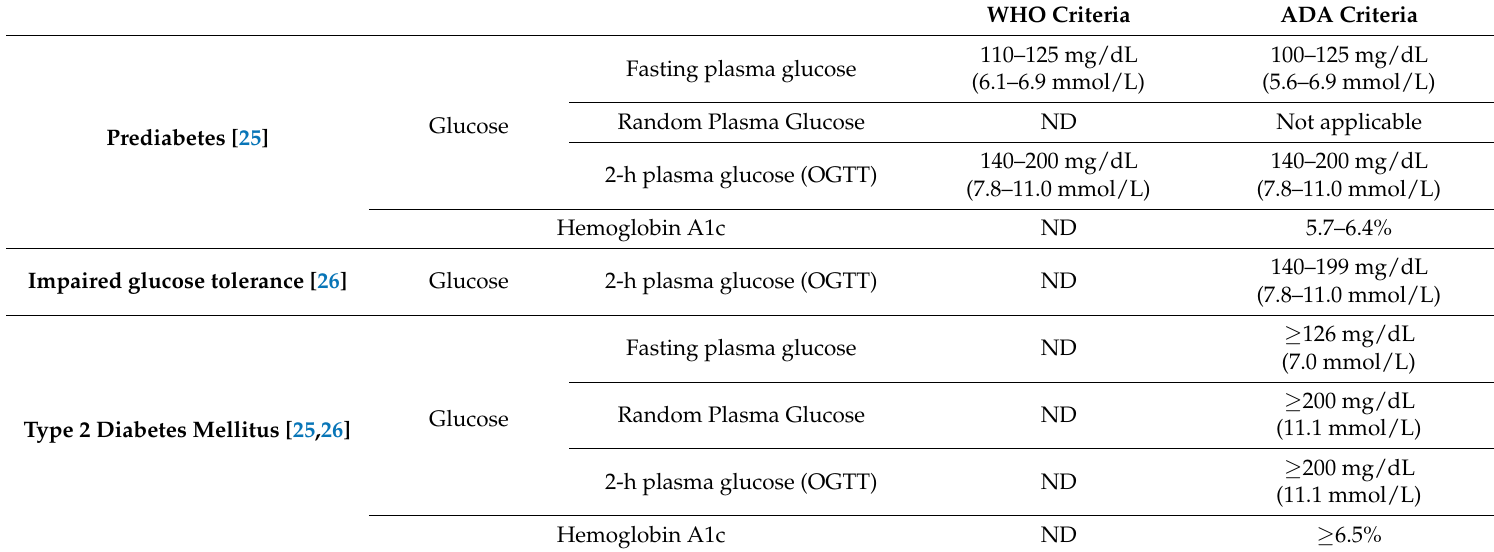
Table 2. Diagnostic criteria for prediabetes, impaired glucose tolerance and type 2 diabetes mellitus in children and